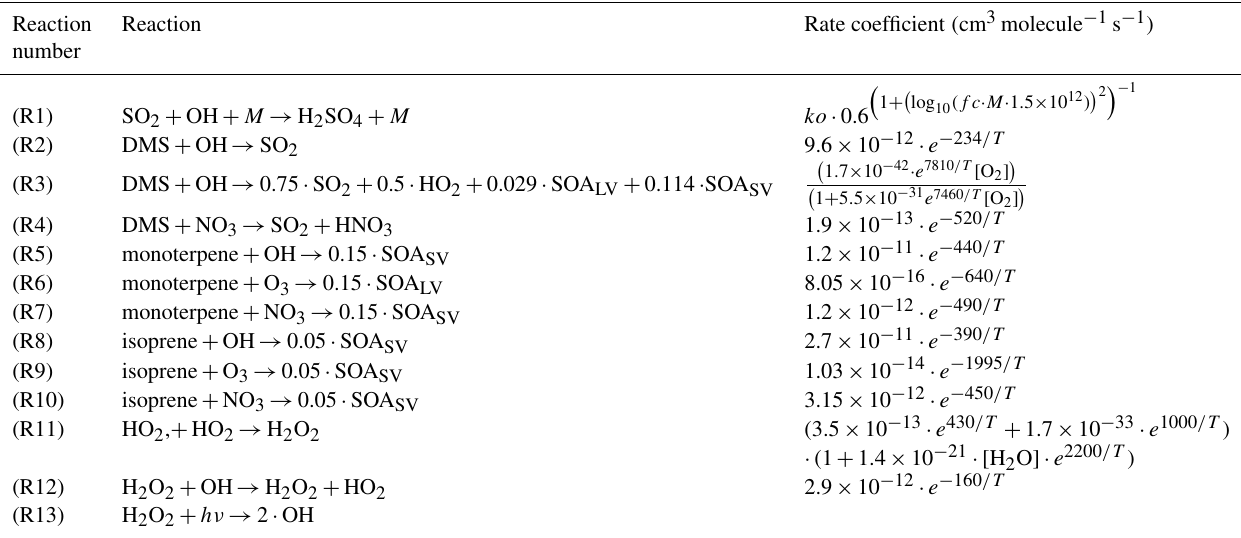
Table 2. Chemical reactions with corresponding rate coefficients. For Reaction (R1), f c = 3 × 10 − 31 · · M ko = fc , where M is the number concentration of all molecules that can act as a third body (cm − 3 ). If the model 1 + (cid:0) fc · M · 1 . 5 × 10 12 (cid:1) does not trace an end product of a chemical reaction, the product is lost in the model and not written down in this table, explaining why the stoichiometry is not exact in all of the